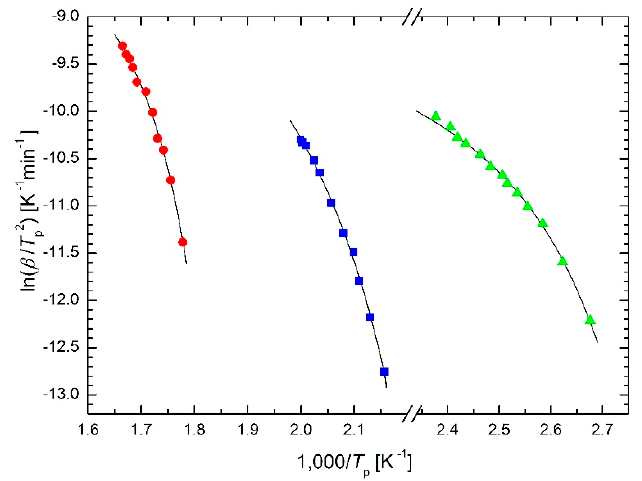
Figure 8. Kissinger plot for crystallization of Ga 7.5 Se 92.5 chalcogenide glass [22] (triangles) and of Si 12.5 Te 87.5 chalcogenide glass [23] (two separated crystallization peaks, squares and circles) based on the modified Arrhenius Equation (23).